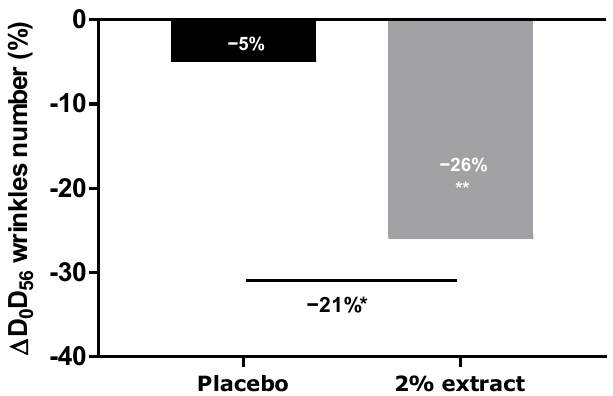
Figure 10. VISIA ® wrinkle analysis of the face after 56 days of application of a cream containing 2% or 0% (placebo) of the extract. A non-parametric paired Wilcoxon test was used to analyze the effects of the duration of application (D0 vs D56), and a non-parametric unpaired Mann–Whitney U test was used to compare products with a significant effect, with * p < 0.05 and ** p < 0.01.